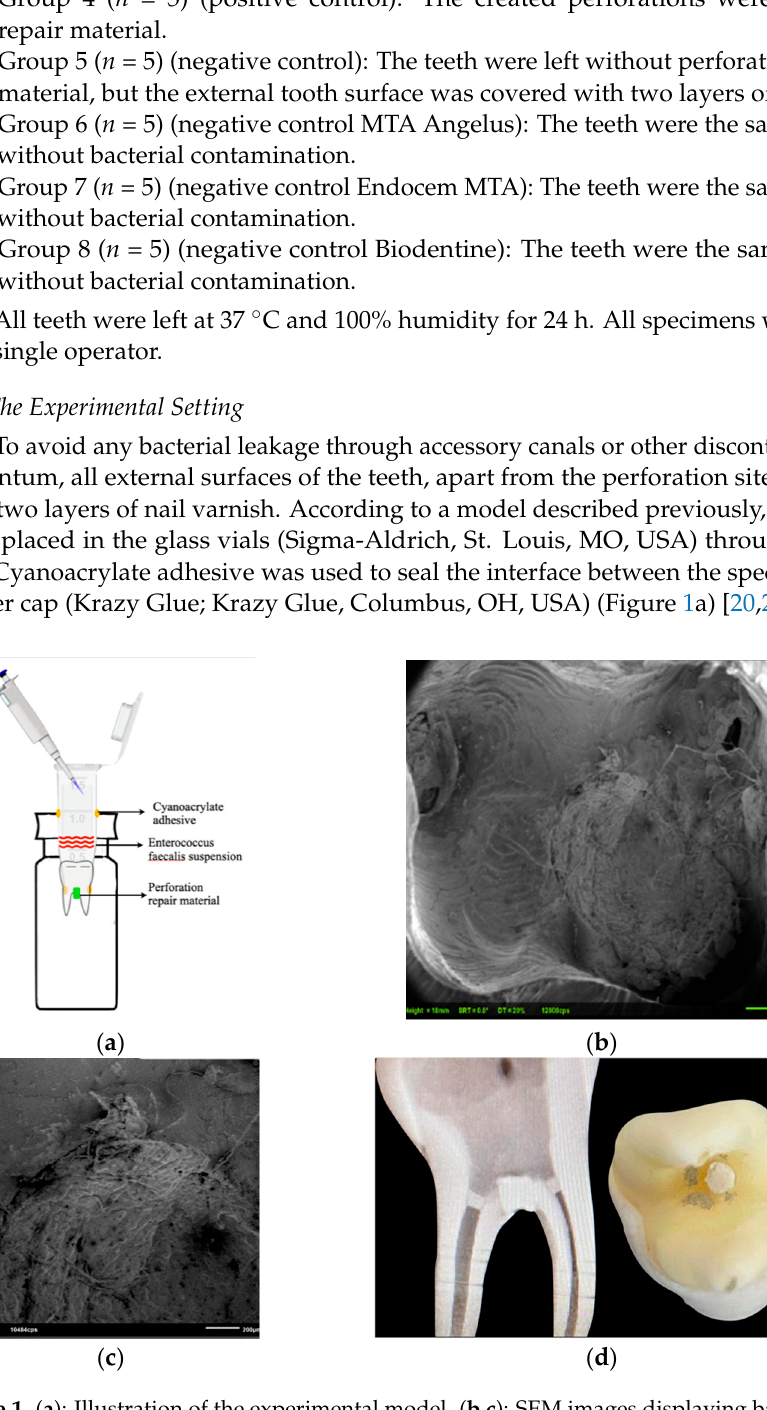
Figure 1. ( a ): Illustration of the experimental model. ( b , c ): SEM images displaying bacterial pene- tration at the perforation site. Clinical and X-ray of lower molar after perforation repair ( d ).